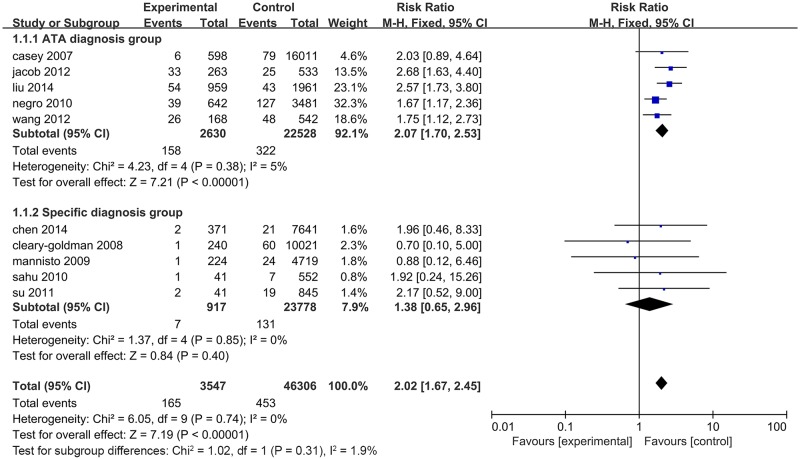
Forest plots for the prevalence of miscarriage risk in untreated SCH patients diagnosed by ATA criteria and specific criteria compared with controls.